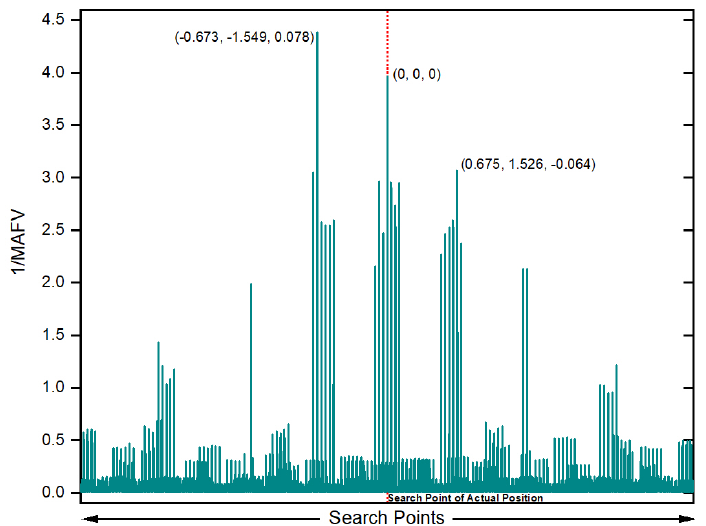
Figure 6. 1/MAFV result for the search points with z coordinate fixed to its reference value, where the red dot line indicates the search point of actual position, the value in the brackets is the error of the solution point referenced to the actual